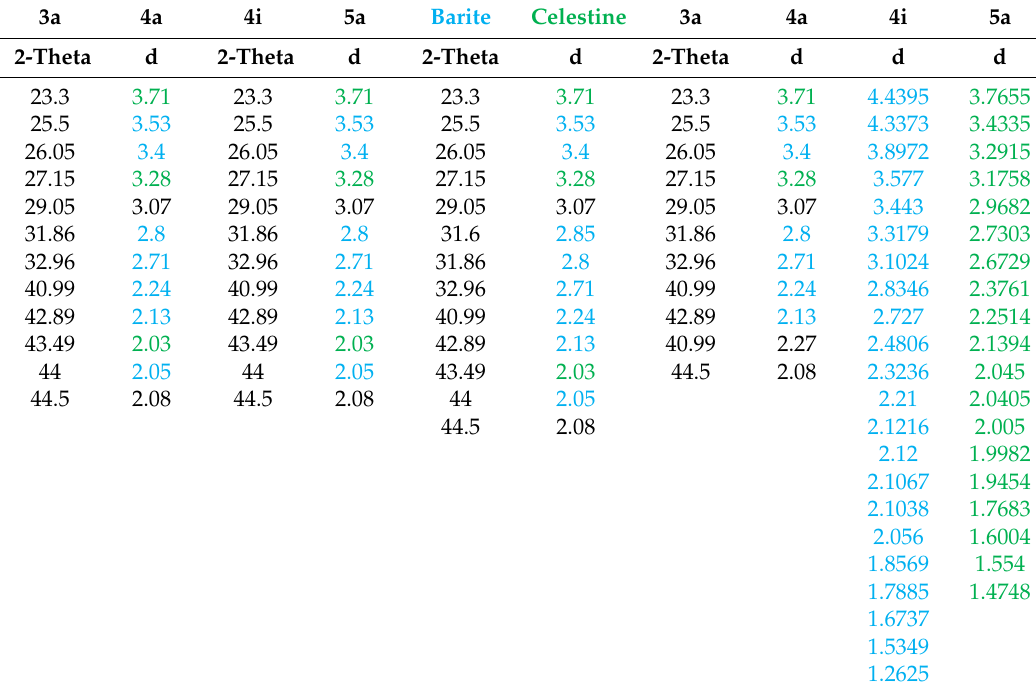
Table 2. D-spacing calculated from XRD patterns of the four distinct synthetic barite crystal morphologies: well-rounded crystals (sample 3a), rosette crystals (sample 4a), elliptical crystals (sample 4i), and euhedral crystals (sample 5a). The barite and celestine standards were taken from Antao